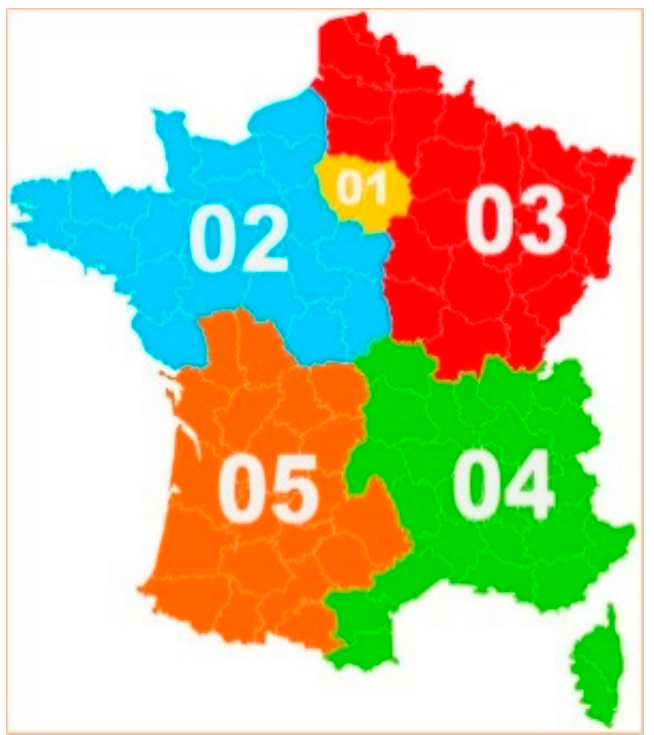
Figure 1. Representation of the five French regions delimited for the qualitative study by focus groups.